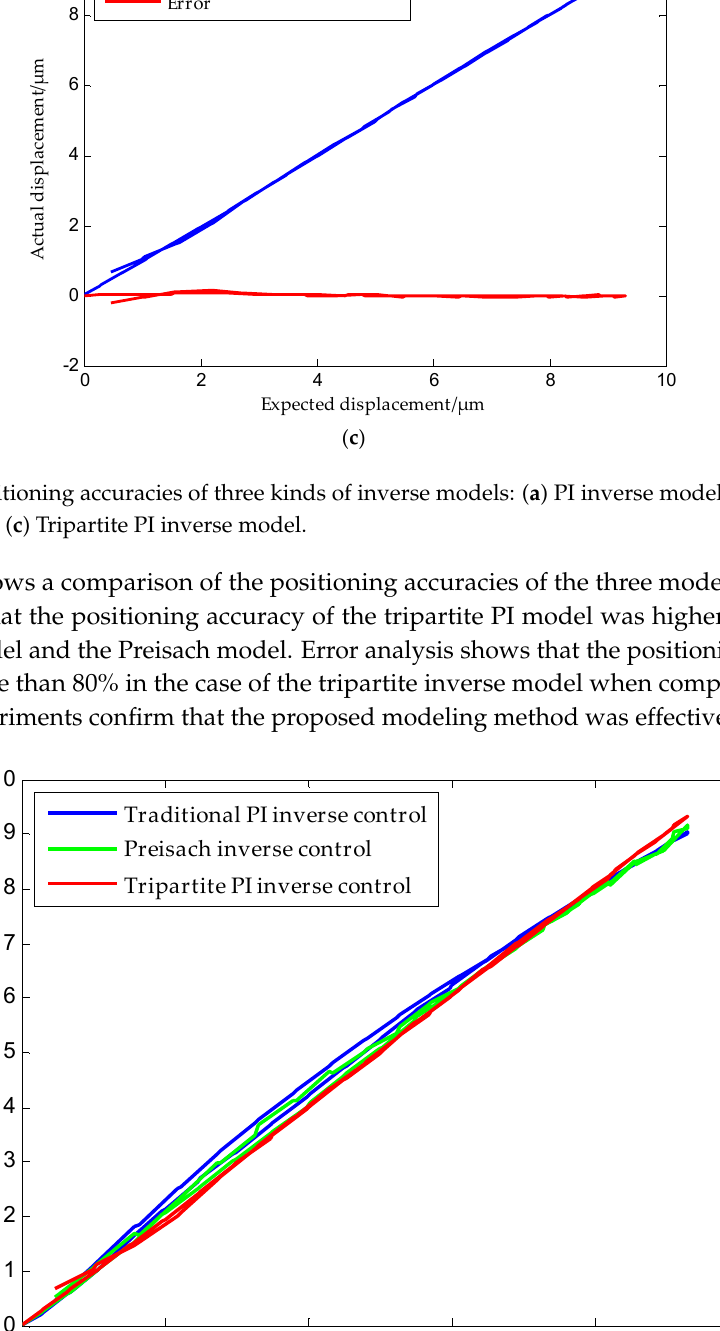
Figure 20. Comparison of the positioning accuracies of different models.